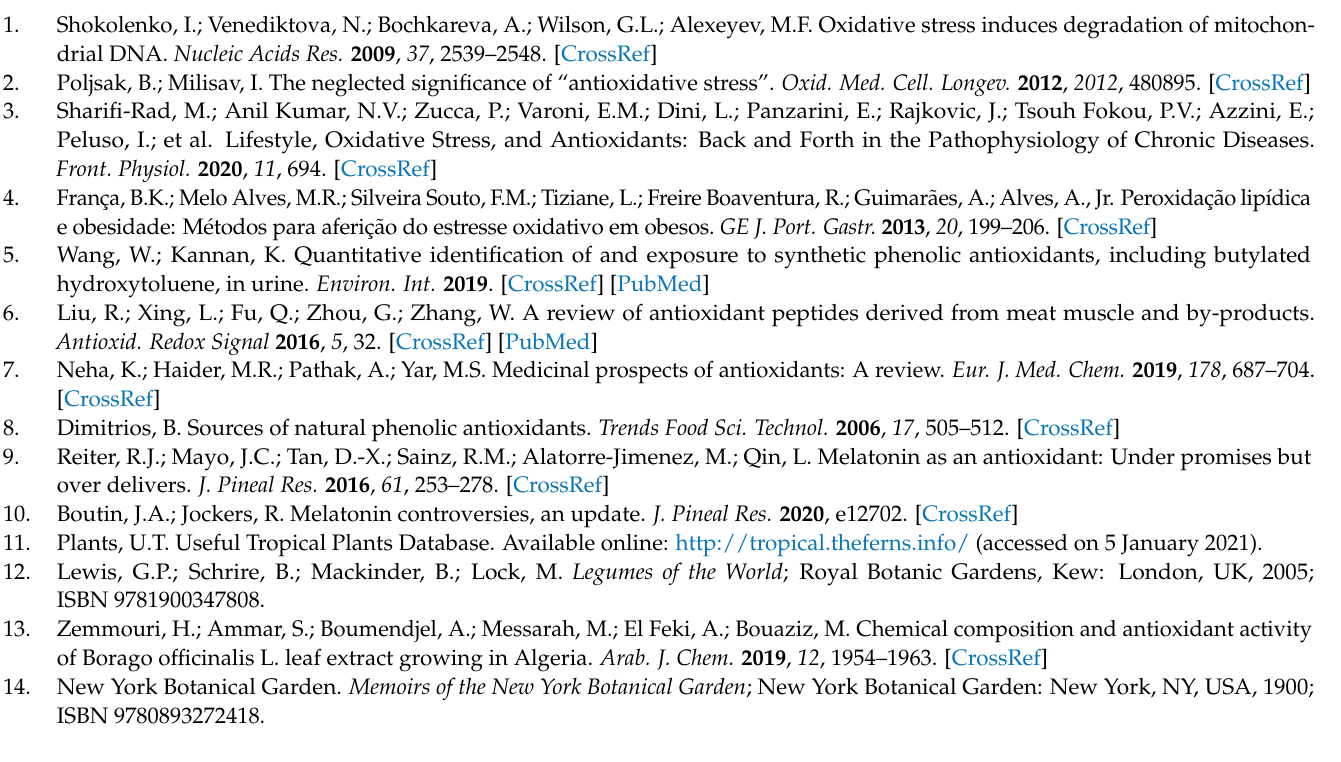
Figure S2. Combined Molecular network for the ethanolic extract (red), methanolic fraction (blue) and ethyl acetate fraction (green) of Chamaecrista diphylla leaves. Figure S3. UHPLC-MS total ion chromatograms (region 3.5 to 17 min) in negative ion mode for Stryphnodendron pulcherrimum leaf extract, showing the 35 dereplicated compounds. (A) Ethanolic extract (EE). (B) Ethyl acetate fraction (Fr-OAcEt). (C) Methanolic fraction (Fr-MeOH). Table S1. In-house database of compounds